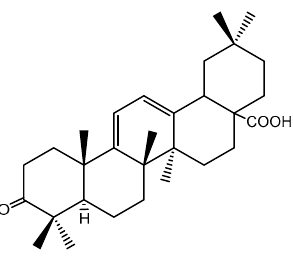
Figure 1. Structure of 3-oxours-oleana-9(11), 12-dien-28-oic acid (Oxy-Di-OA).